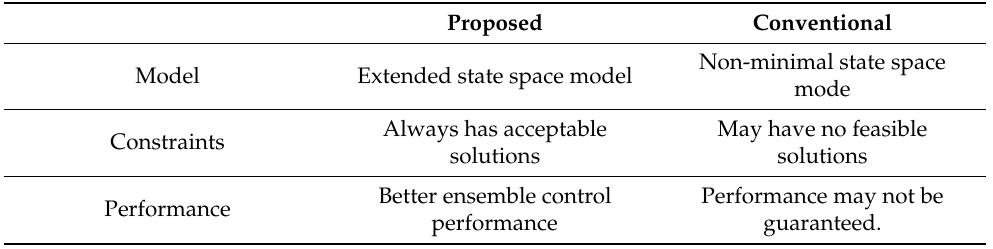
Non-minimal state space mode May have no feasible solutions Performance may not be